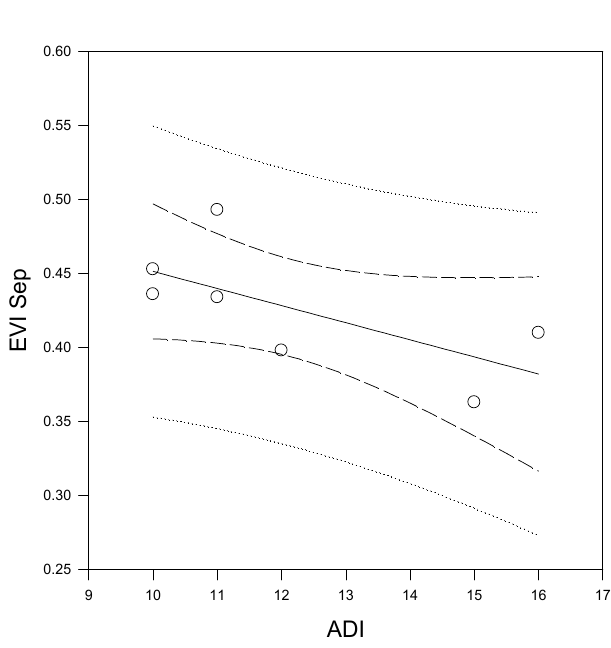
Figure 9. EVI - September values of Riparian Vegetation relation with the Anthropogenic Disturb Index (ADI). R 2 = 0.448, P = 0.100.